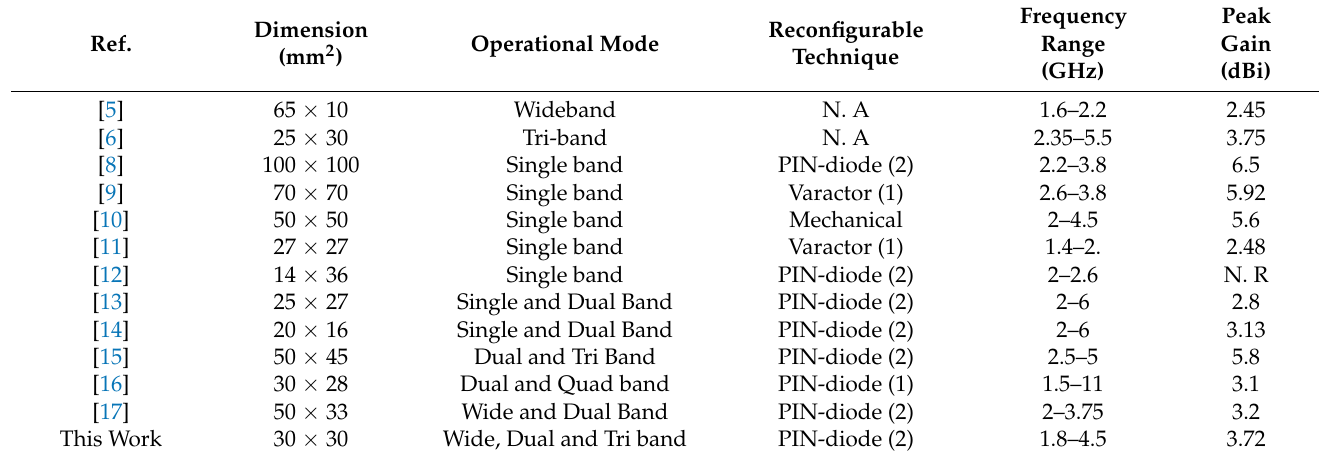
Table 3. Comparison of the proposed antenna with state-of-the-art works for similar applications. Dimension Operational Mode Ref. (mm 2 )